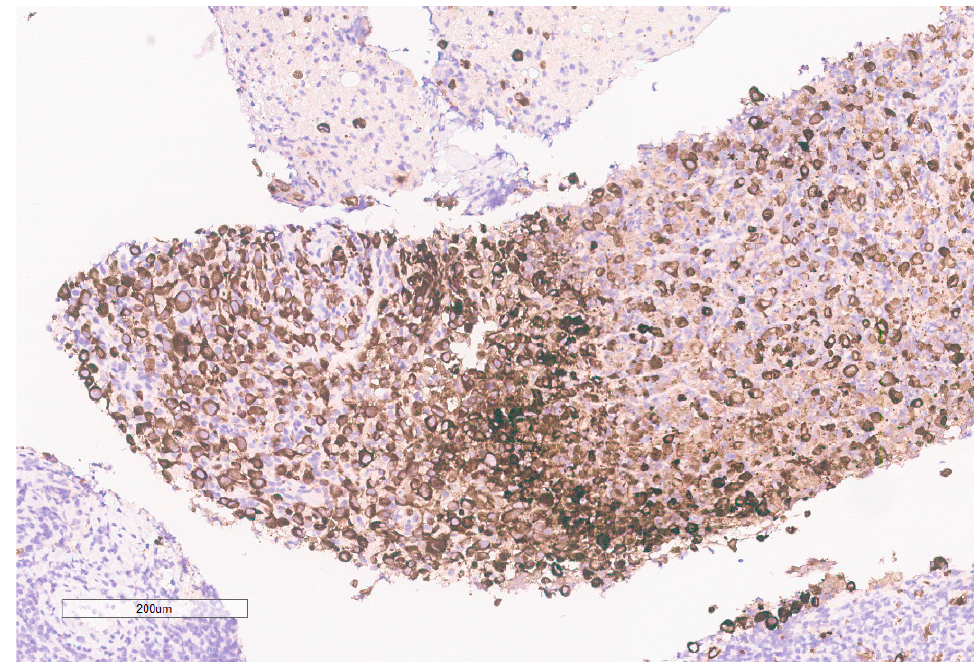
Figure 7. High grade carcinoma with necrosis; tumor cells have a rhabdoid morphology.